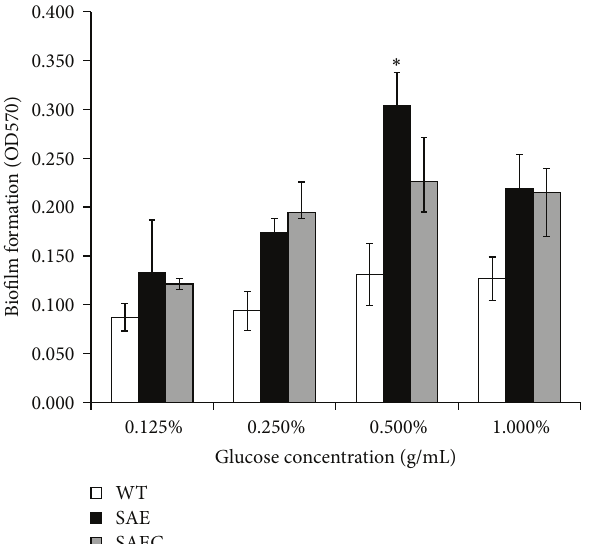
Figure 4: Effect of glucose on SAE, WT, and SAEC biofilm formation. SAE, WT, and SAEC biofilmswere formedin theabsence (black bars) or presence of glucose (0.125%, 0.25%, 0.5%, and 1%); then the biofilms were washed and then stained with crystal violet. Their retained biomass was quantified by measuring the absorbance of each well at 570 nm. Mean values and standard deviations from three independent experiments are shown, ∗ 𝑃 < 0.05 .